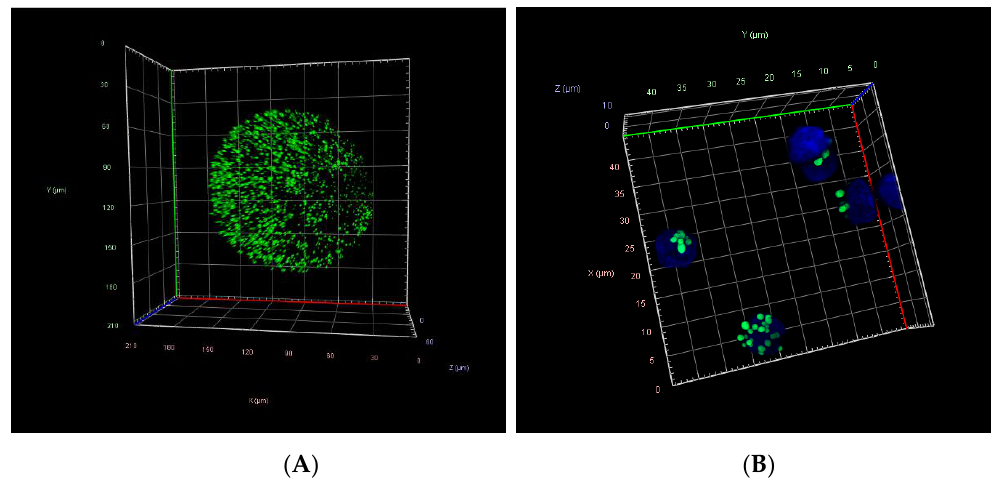
Figure 4. Confocal 3D projections of fluorescently stained oocytes ( A ) and cumulus cells ( B ) with BODIPY 493/503 (green — lipid droplets) and 4 ’ ,6-diamidino-2-phenylindole (DAPI; blue — nuclei).